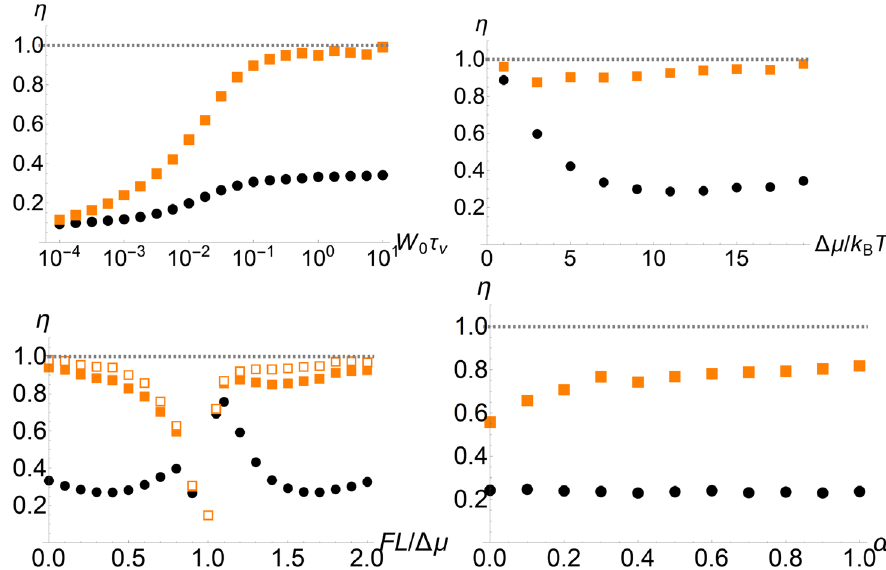
FIG. 1. The transport efficiency [Eq. (48)] for the displacement of the probe attached to the molecular motor as a function of different parameters. The black circles correspond to the TUR for the displacement z only, while the solid orange squares show the CTUR [Eq. (25)] including the correlations between the displacement and its local mean value ¯ z . The data are obtained by numerical simulations of Eq. (15) with W 0 τ v ¼ 10 , U 0 ¼ 50 k B T , Δ μ ¼ 19 k B T , α ¼ 0 . 1 , γ ¼ 2 . 5 × 10 3 , and F ¼ 0 , except where noted differently. Top left: as a function of the base activity W 0 . The horizontal axis is scaled by the timescale τ v ¼ γ k B T= ð kL Þ 2 [22]. Top right: as a function of the chemical potential difference Δ μ . Bottom left: as a function of the external load F . The empty orange squares are Eq. (25) with a numerically optimized observable; see Eq. (49). Bottom right: as a function of the asymmetry parameter α